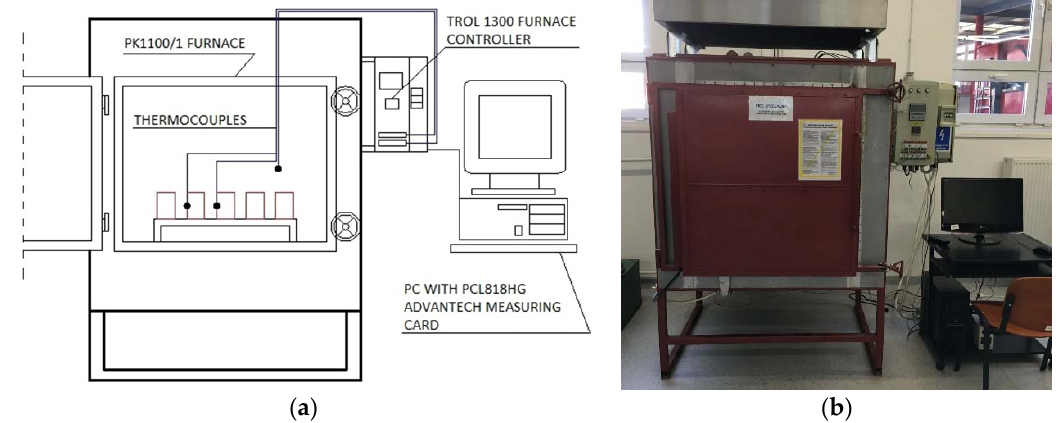
Figure 2. The furnace used in the study: ( a ) scheme; and ( b ) real image.